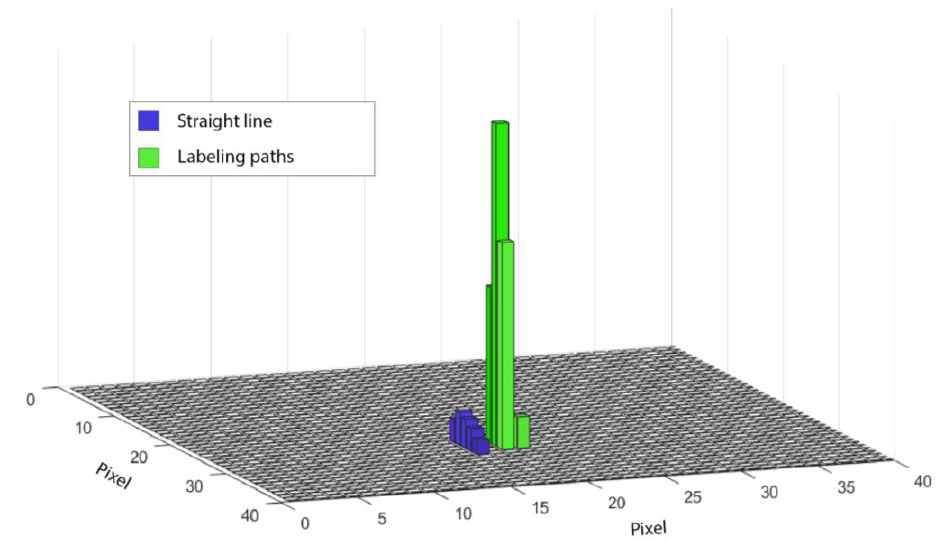
Figure 8. Frequency distribution of the single brightest pixel on the sensor at a laser power of 460 W and a scan speed of 1 m/s.